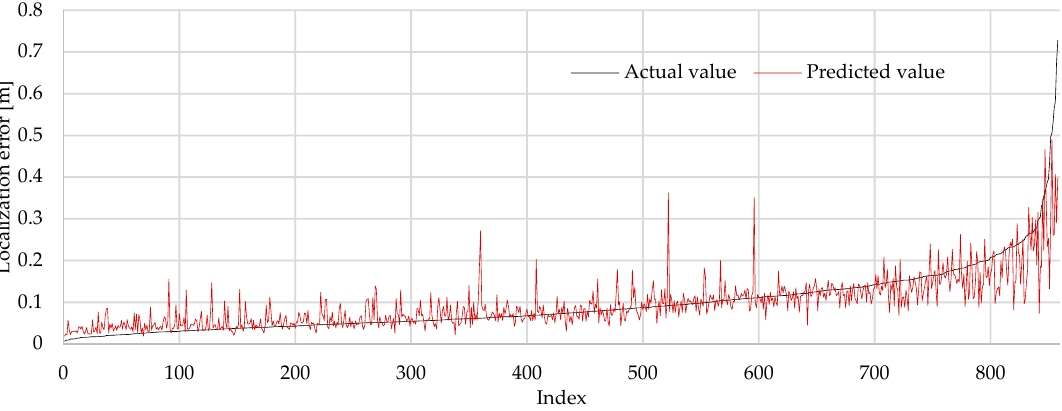
Figure 10. Predicted (red) vs. actual (black) value of localization error, sorted by actual value (Model 8, test data).